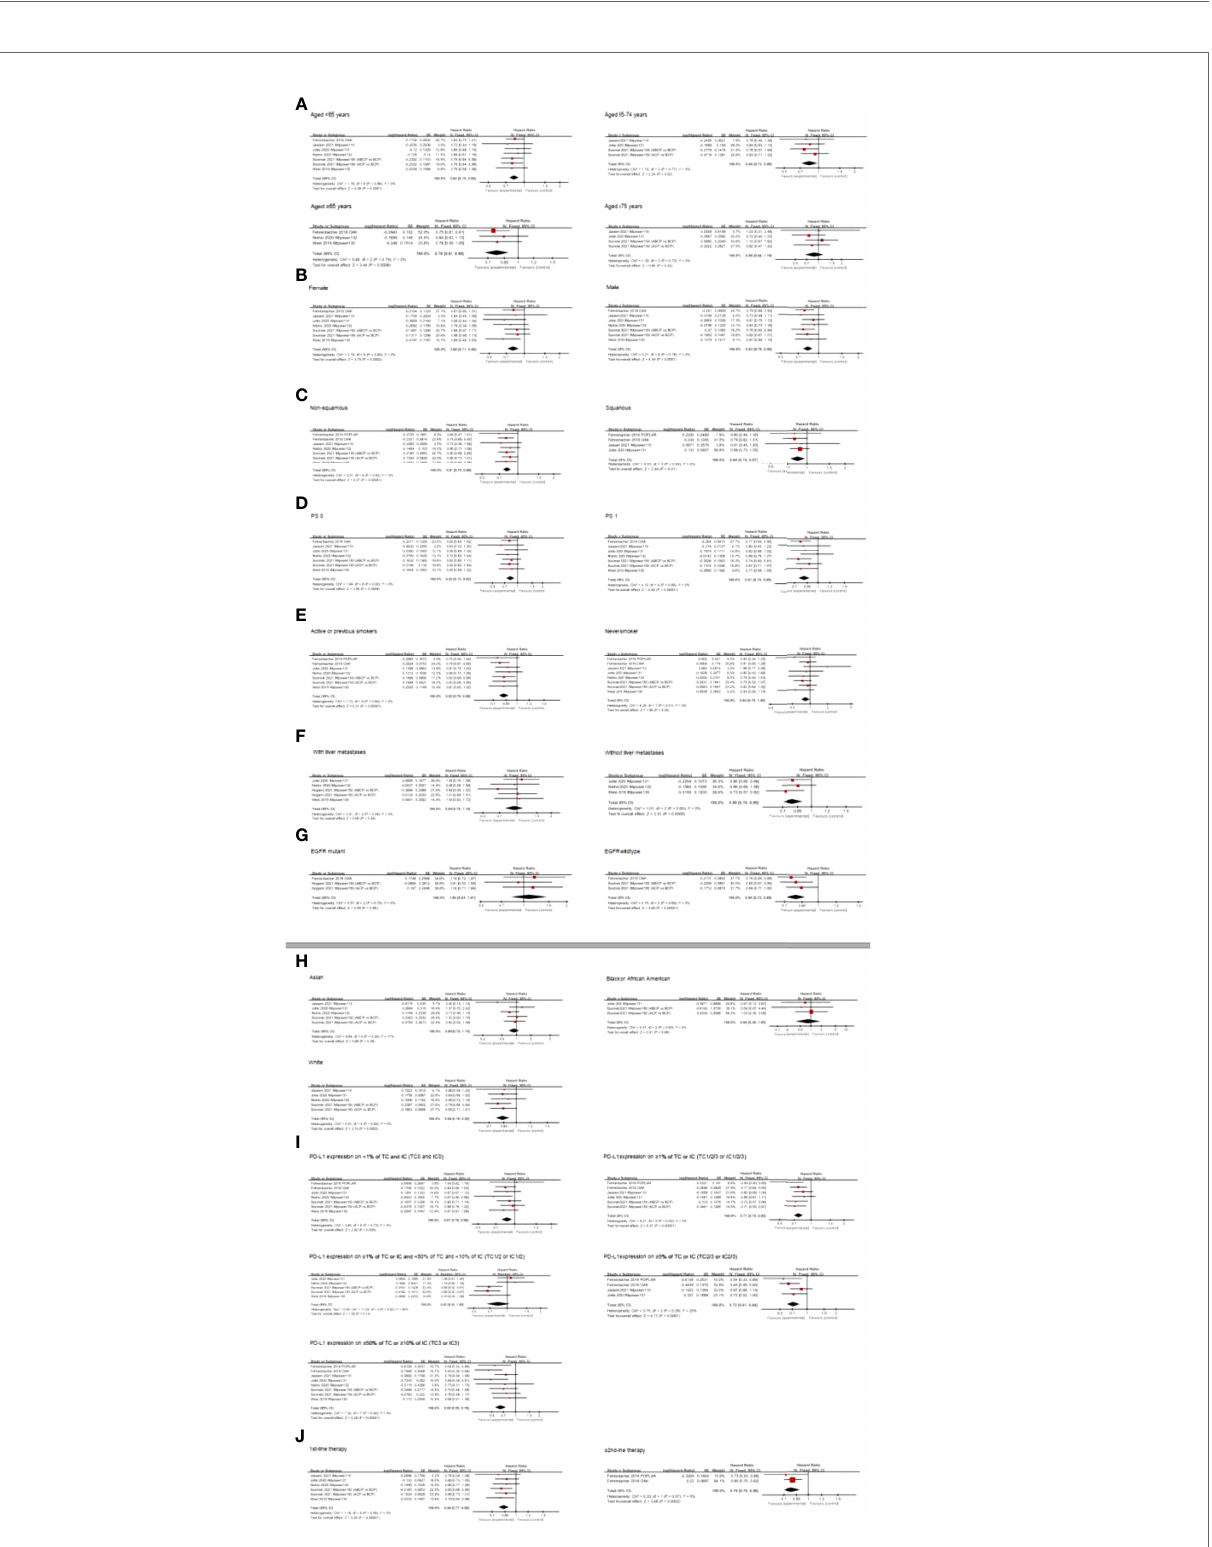
FIGURE 4 | Forest plots of HRs comparing OS between atezolizumab-based therapy and chemotherapy-based therapy with respect to (A) age group, (B) gender, (C) histological type, (D) PS score, (E) smoking status, (F) liver metastases status, (G) EGFR mutation status, (H) race, (I) PD-L1expression, and (J) treatment